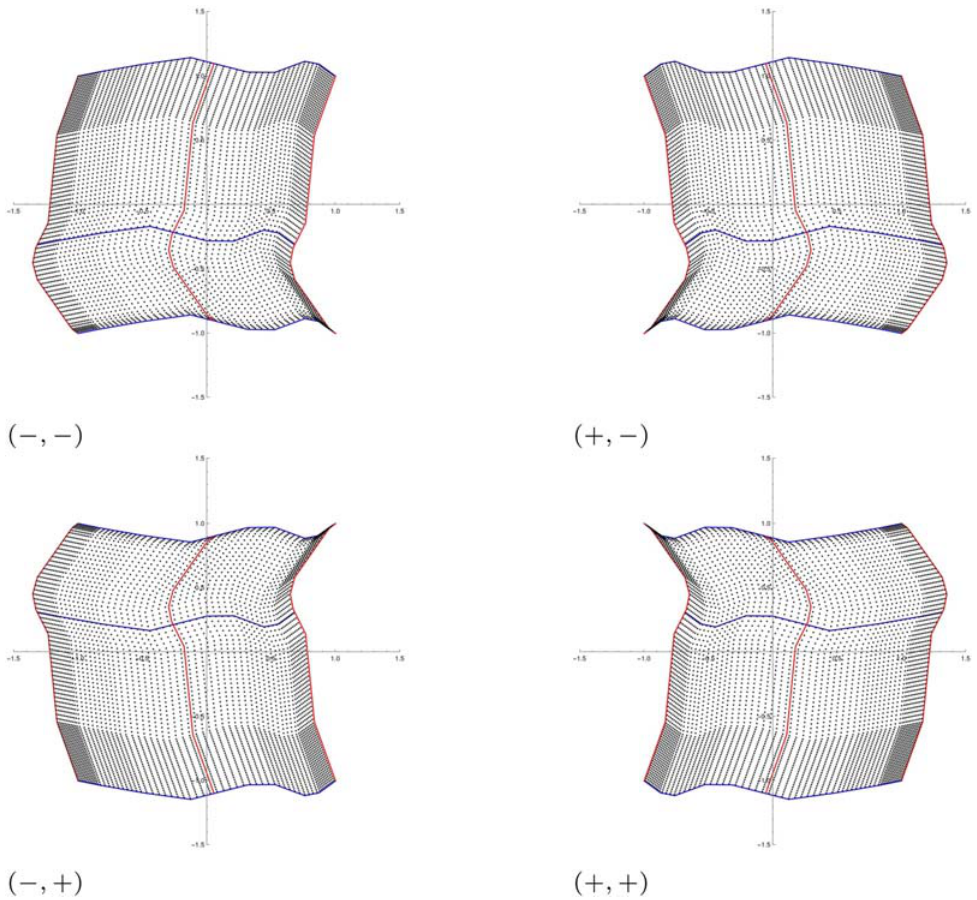
Figure A1: Images of the four possible orientations of the three - dimensional Fiedler - carpet of the graph in Figure